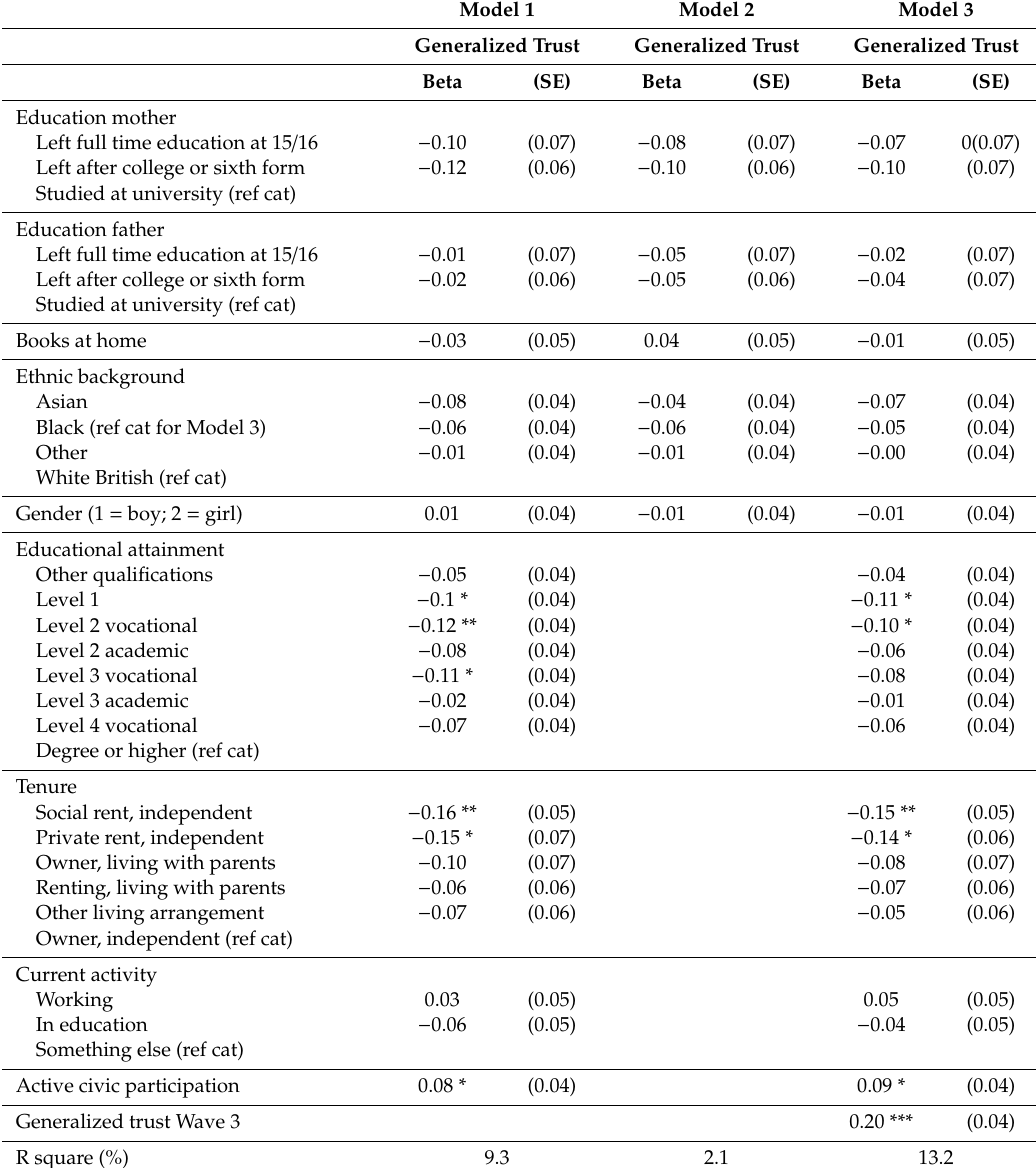
Table 6. Determinants of generalized